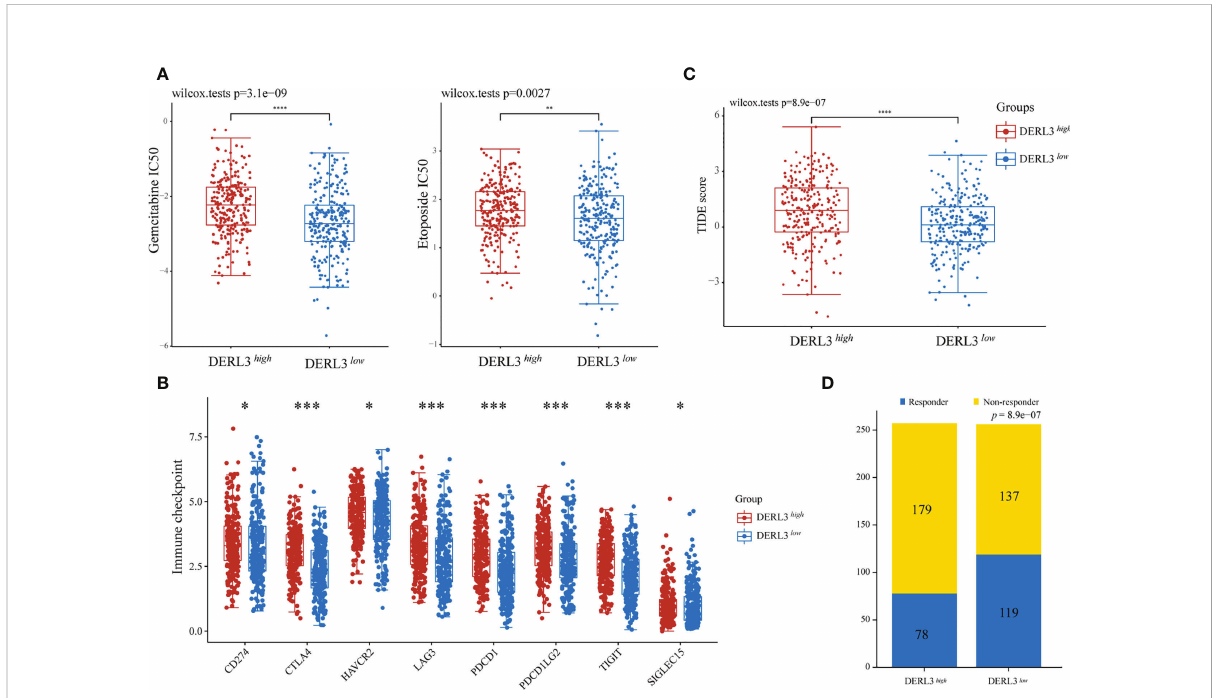
FIGURE 4 The correlation between DERL3 expression and chemotherapy and immunotherapy. (A) The IC50 values of gemcitabine and etoposide toxicity in differentially DERL3 expressed groups. (B) Expression of immune checkpoint molecules related to DERL3 differential expression in LUAD patients. (C) Prediction of immunotherapy response using the TIDE computational framework. (D) Comparison of populations in responders and non-responders to immunotherapy based on TIDE scores. (*p < 0.05, **p < 0.01, ***p < 0.001, ****p <